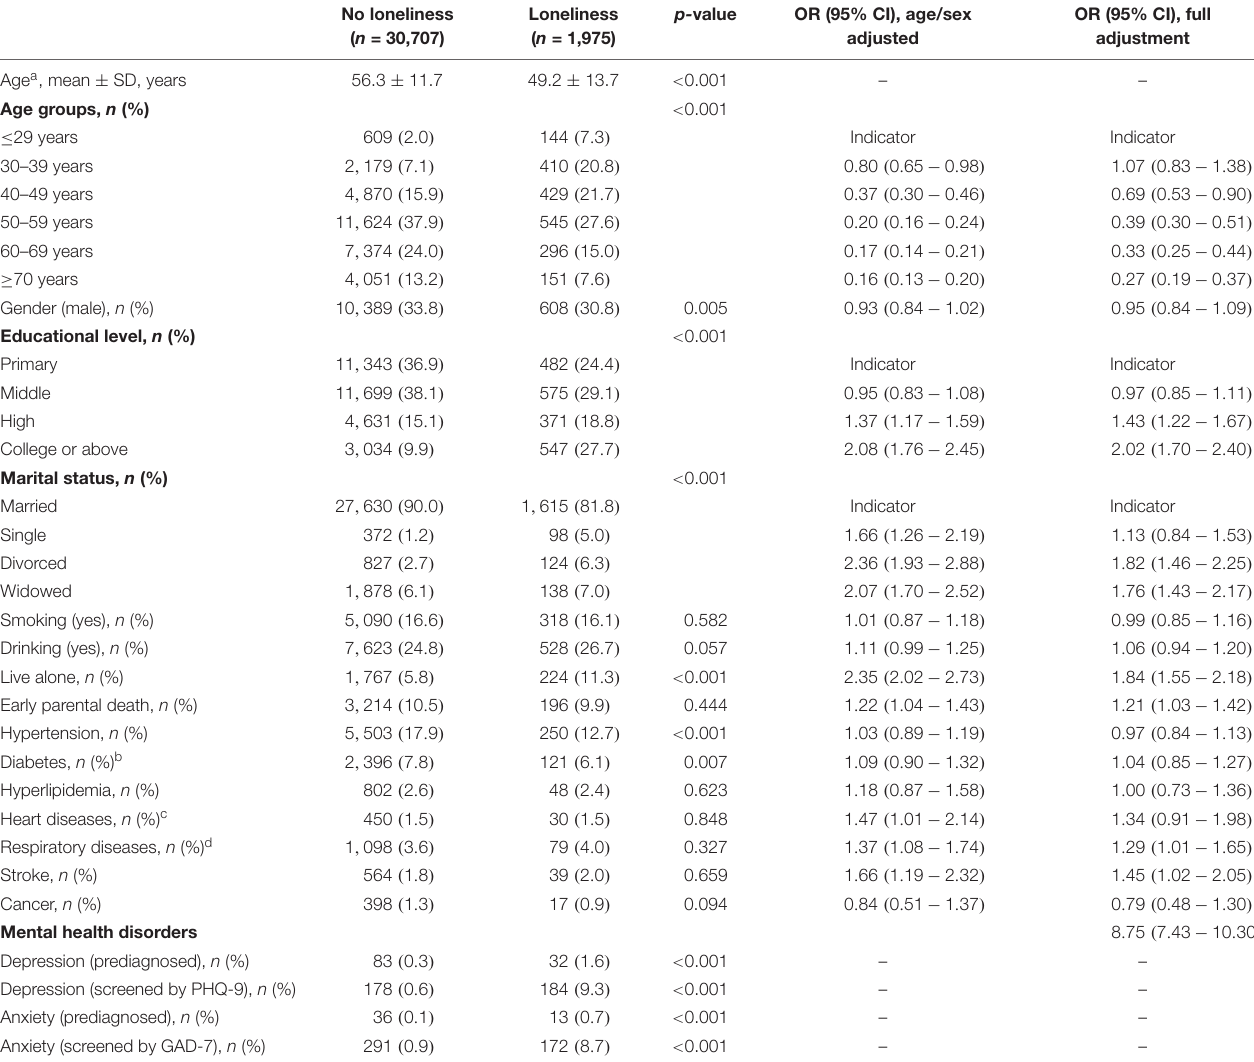
TABLE 1 | Characteristics of participants with or without loneliness and respective